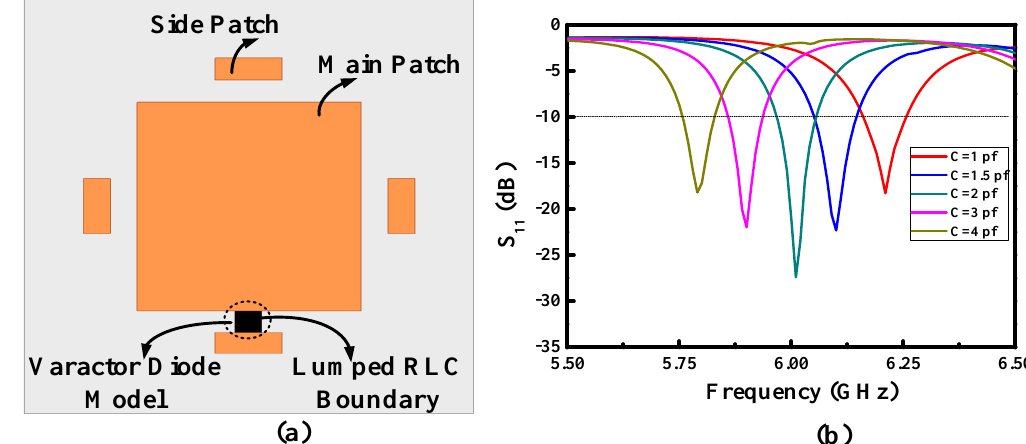
Figure 3. ( a ). Details of the simulation model (one smaller patch is connected to the larger main patch). ( b ). The return losses at different frequencies.